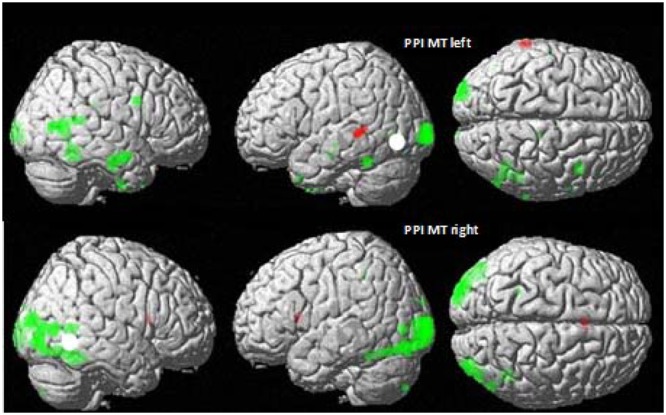
MT/V5 Psychophysiological interactions in CSLM and speech AV. Psychophysiological interactions (PPI) from the left (top) and right MT/V5 (bottom) for deaf CS group (in green) and NH group (in red). p < 0.001 uncorrected for multiple comparisons.